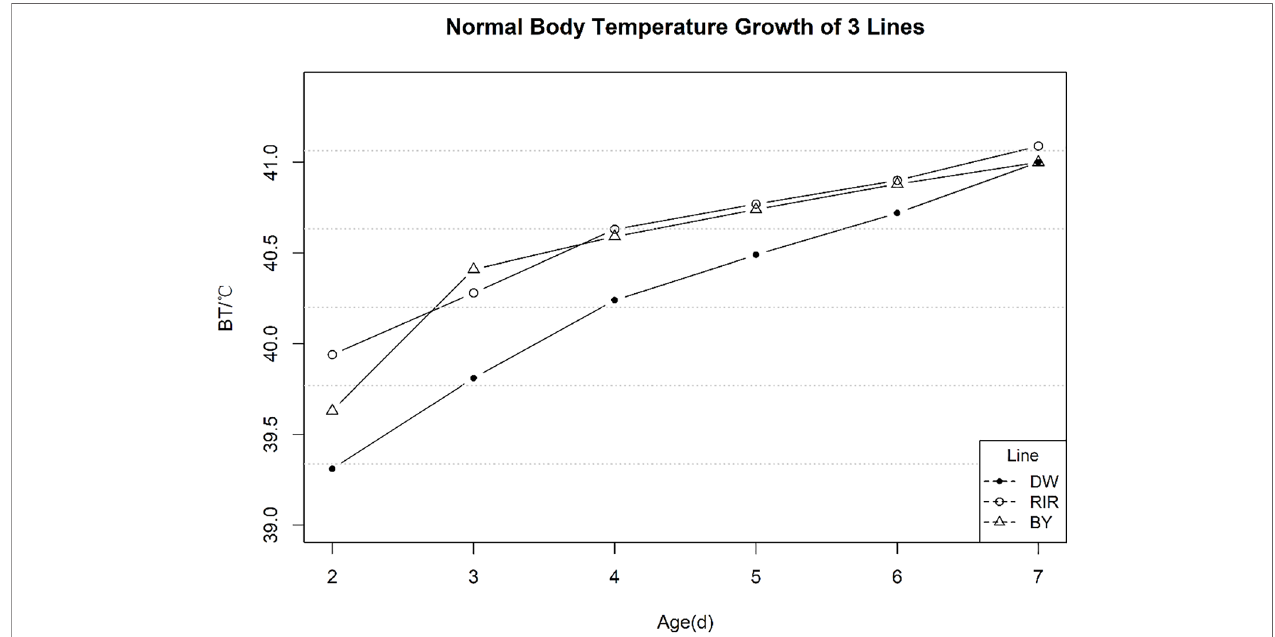
FIGURE 1 | Normal Early Temperature of 3 Lines.